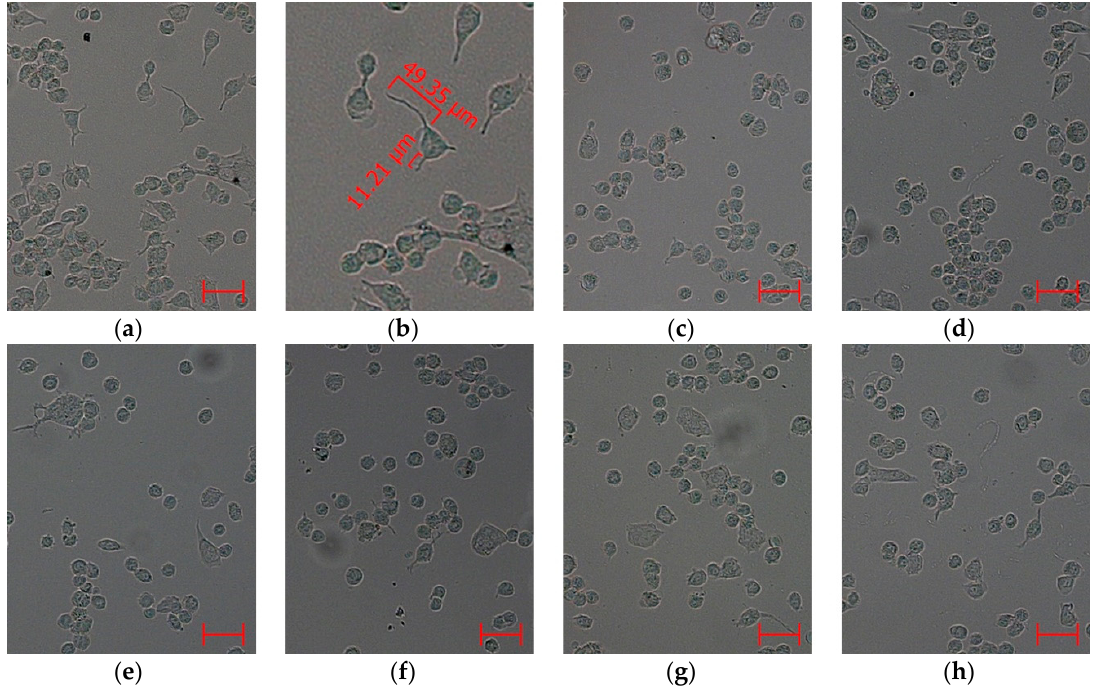
Figure 5. Images of Neuro-2a cells incubated without PQ ( a , b ), with PQ ( c ), and with investigated compounds 1 ( d ), 2 ( e ), 3 ( f ), 4 ( g ), and 5 ( h ). All compounds were used at concentrations of 10 µ M. PQ were used at a concentration of 500 µ M. Scale bar is 50 µ m.